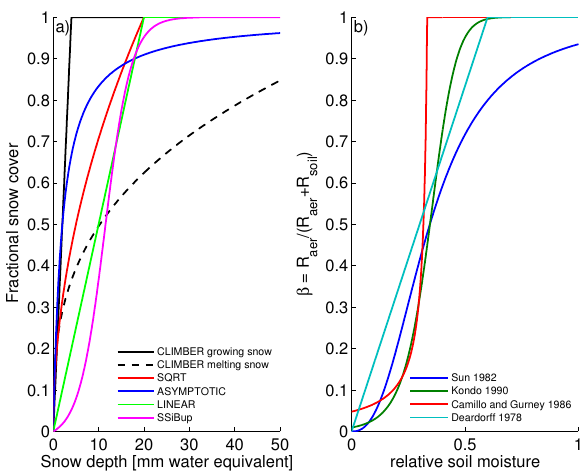
Fig. 1. Parameterizations of (a) subgrid snow cover fraction (Liston and Elder, 2004) and (b) surface resistance (Mahfouf and Noilhan, 1991). R soil is the surface resistance and R aer is the aerodynamic resistance to the transfer of water from the surface to a reference height, assumed to be 50sm − 1 . See text for further